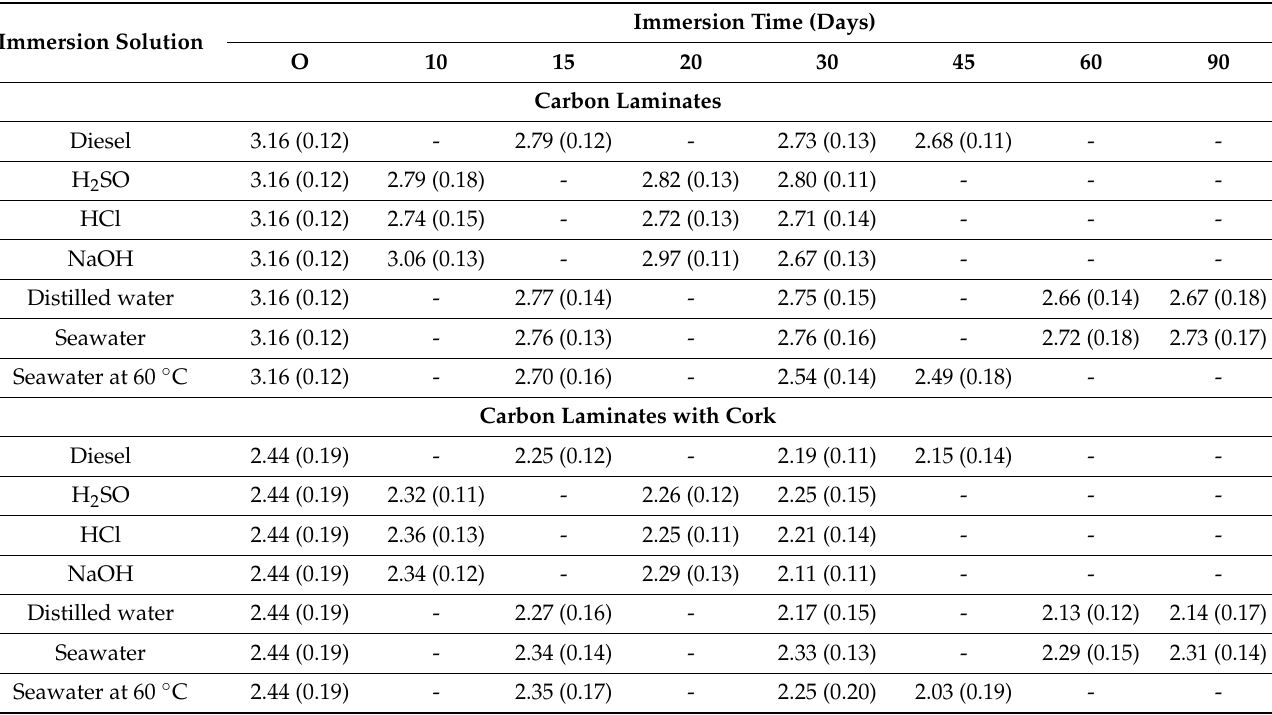
Table 3. Maximum load obtained for different harsh solutions and immersion time (values in kN).